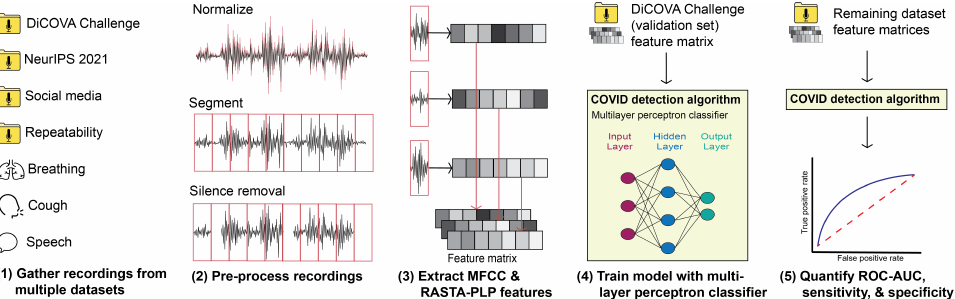
Figure 1. The proposed COVID-19 detection system pipeline, consisting of (1) data collection, (2) pre- processing, (3) feature extraction, (4) classification, and (5) performance evaluation stages.